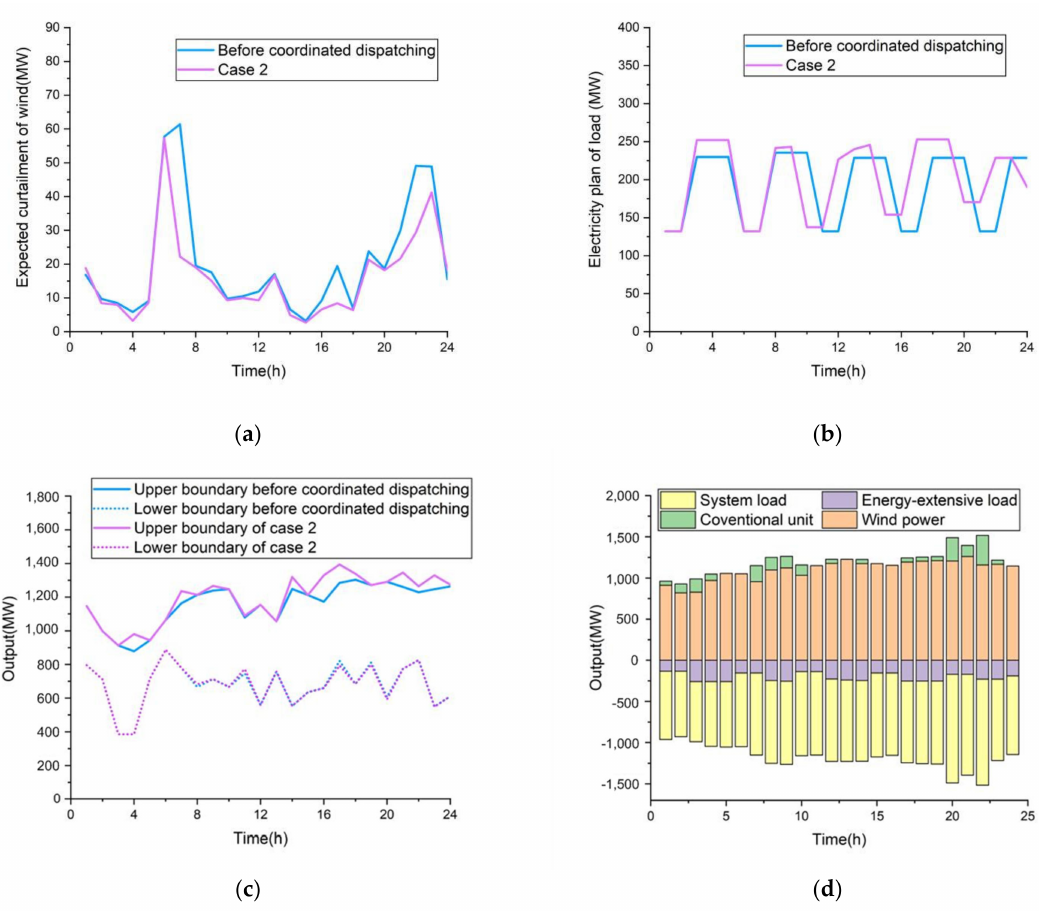
Figure 12. ( a ) Curves of expected curtailment of wind; ( b ) Curves of electricity plan of load; ( c ) ARWP boundary of power grid; ( d ) System coordination dispatching